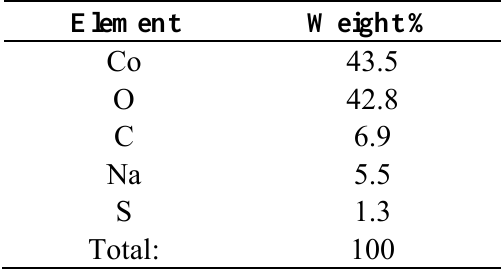
Table 2. Composition of CoOOH/CNT